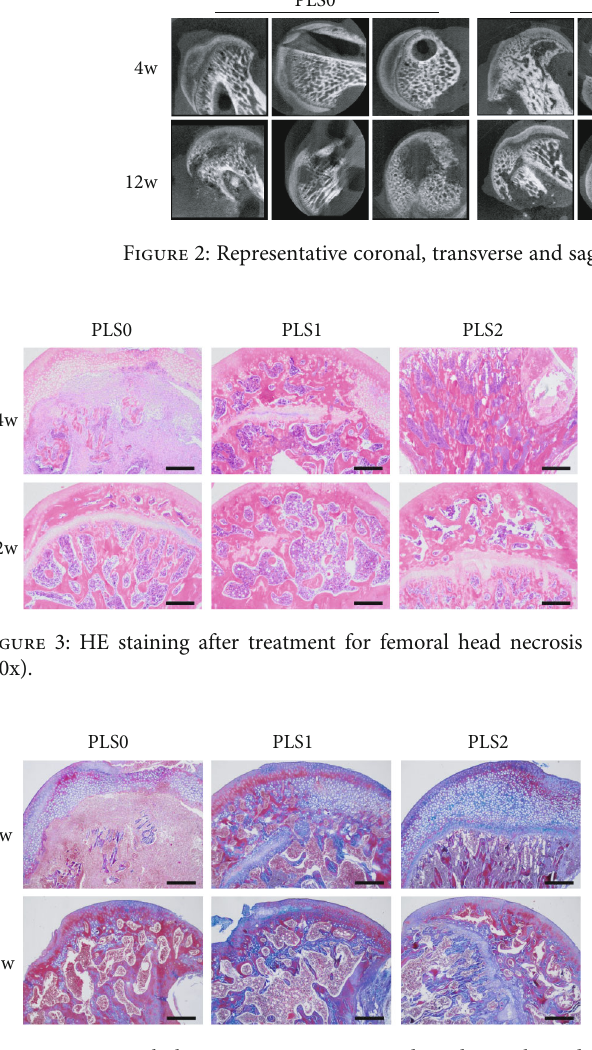
Figure 4: Histopathology Masson staining conducted 4 weeks and 12 weeks after ONFH treatment (40x).